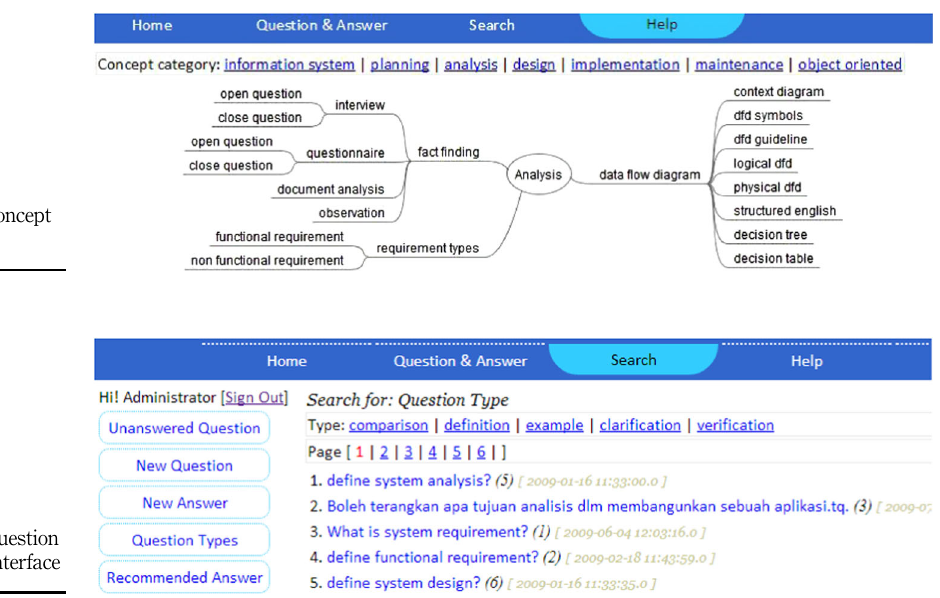
Figure 11. Example of question type search